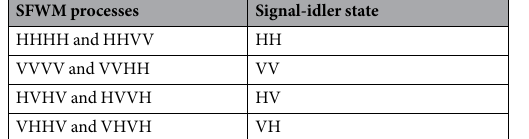
be from 10 to 15 dB cm − 1 . In these structures the waveguide widths have a considerable effect on the dispersion of the TE mode due to the high index contrast (between air and Al 0.25 Ga 0.75 As) and high mode confinement. The zero-dispersion wavelength (ZDW) can be positioned anywhere in the entire C-band by controlling the